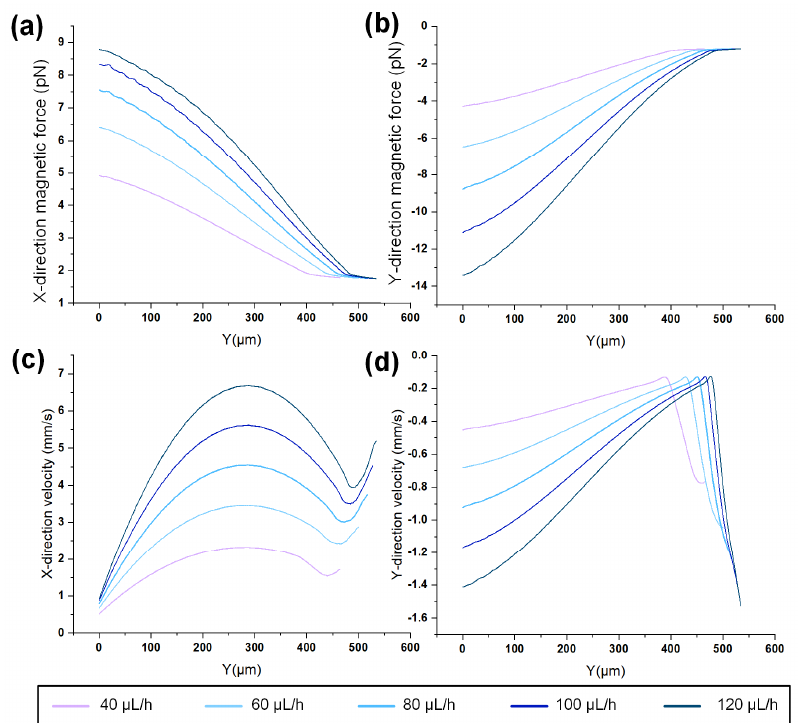
Figure 3. The magnetic force on the beads not impinging the branched wall in x ( a ) and y ( b ) direction with NdBFe magnet at position 3. The velocity of those beads in x ( c ) and y ( d ) direction increased a lot with the 𝑢 𝑓𝑙 from 40 μ L/h to 120 μ L/h. The horizontal axis Y represents the vertical distance from the bead to the bottom edge.